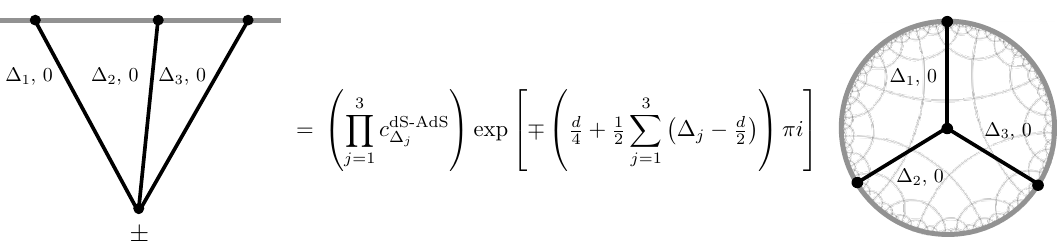
Figure 11. The contribution from the ± branch of the in-in contour to a three-point contact diagram of scalar fields in dS d +1 is given by the corresponding diagram in EAdS d +1 multiplied by a constant phase which implements the Wick rotation (2.13) and the factors c dS-AdS for the change in two-point